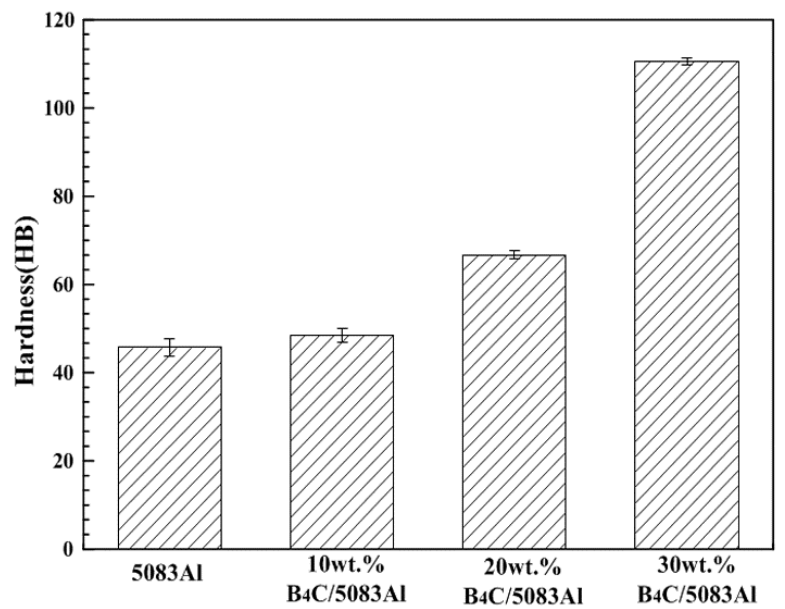
Figure 5. Microhardness of pure Al 5083 matrix and B 4 C/Al 5083 composite with 10–30 wt % B 4 C content.